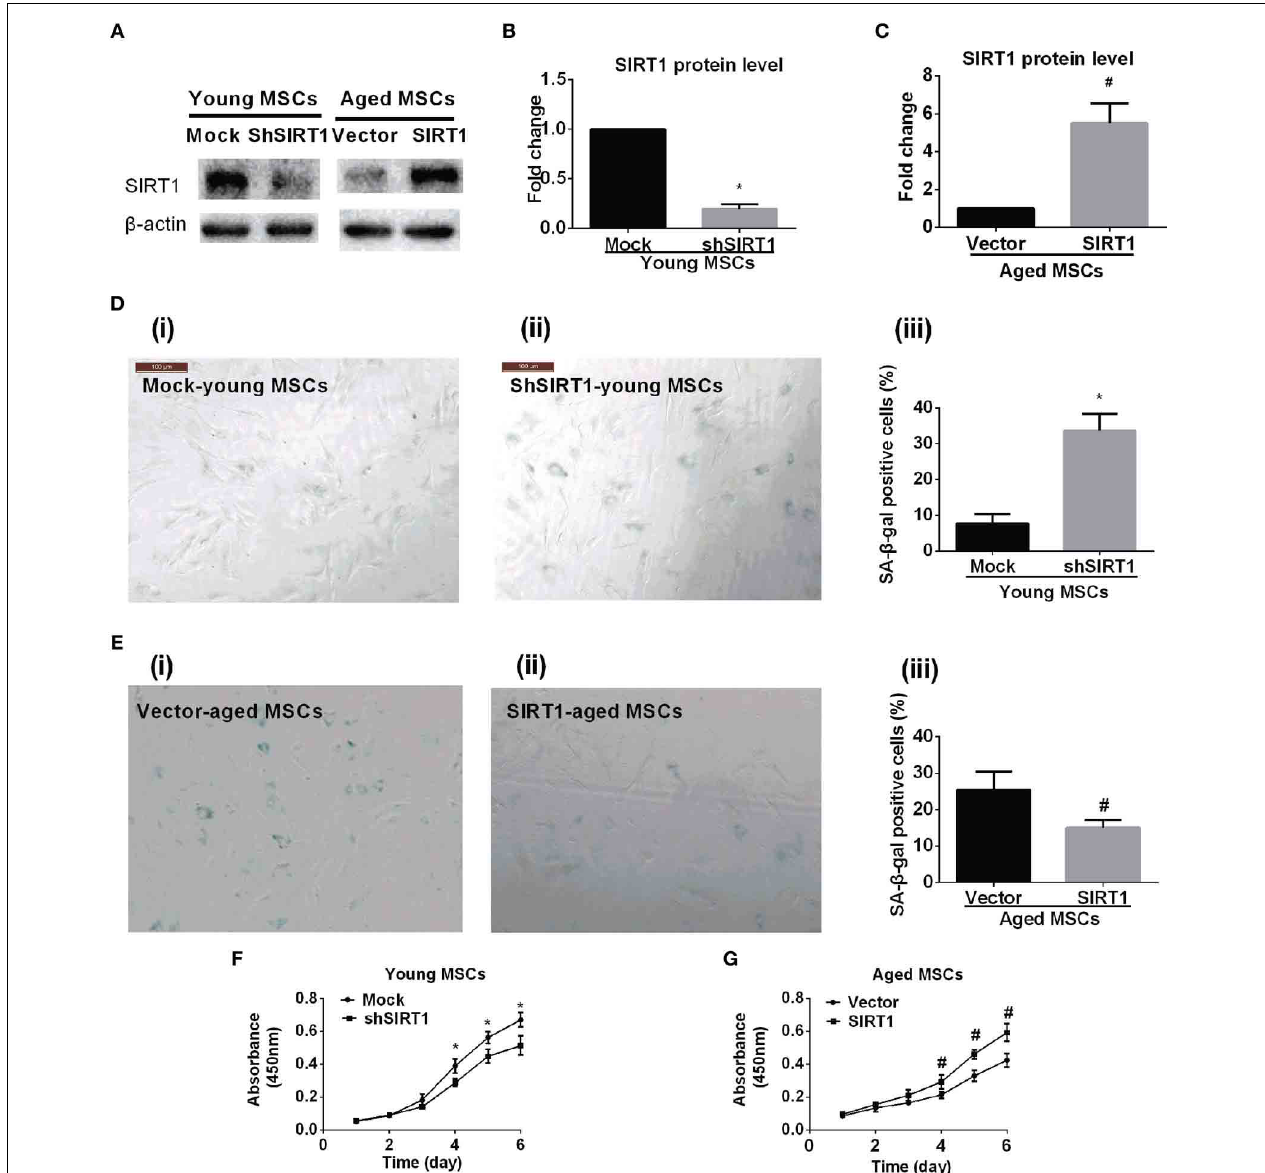
FIGURE 2 | SIRT1 mitigates age-related senescence of MSCs. SIRT1 protein levels in genetically modified young and aged MSCs were evaluated by Western Blot. Representative protein bands were shown in (A) and quantified in bar graph (B,C) . Representative images of SA- β -gal staining for both young MSCs that were transfected with either mock- or shSIRT1-vectors (shown in D(i) and D(ii) , respectively) and aged MSC transfected with either empty